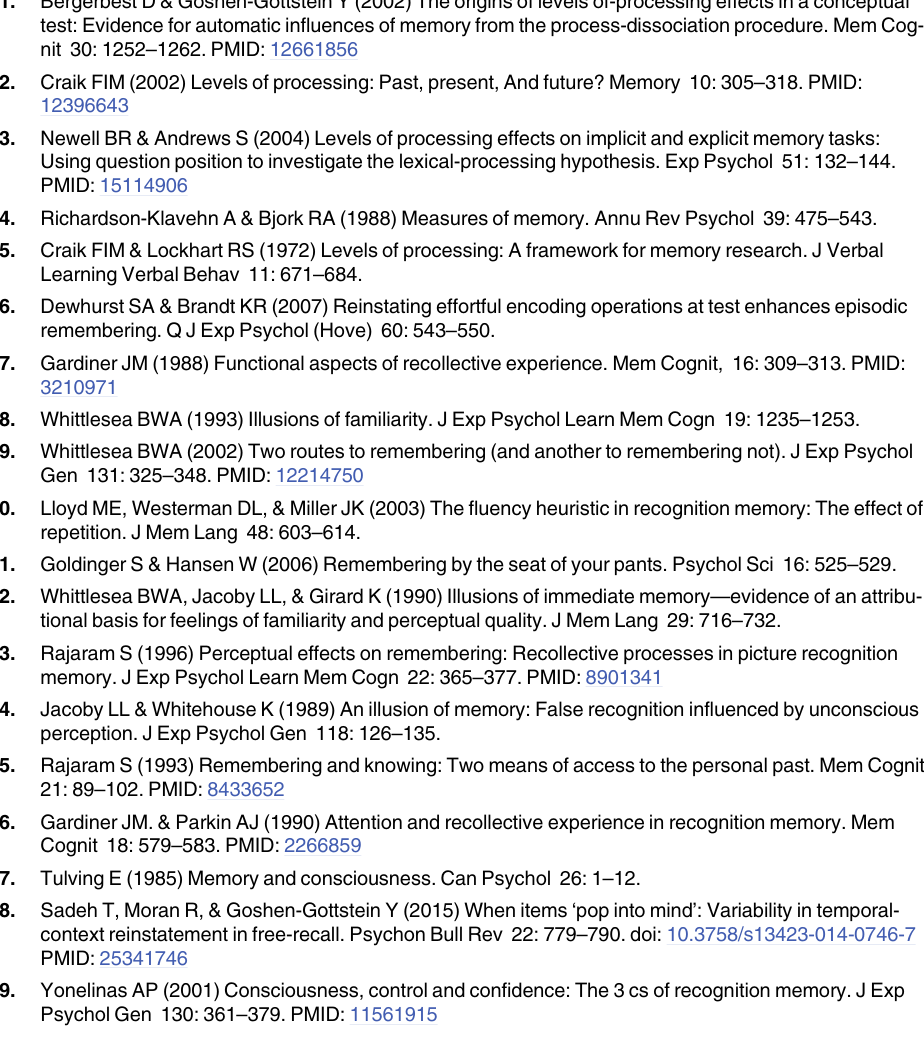
S2 Table. Mean estimates (and SE) of the proportion of Remember and Know responses hit rates, as a function of Attentional: Full, divided at encoding, and divided at retrieval. S3 Table. Mean estimates (and SE) of the proportion of Remember and Know responses hit rates, as a function of Attentional-load (High, Low) and Memory stage (Encoding,